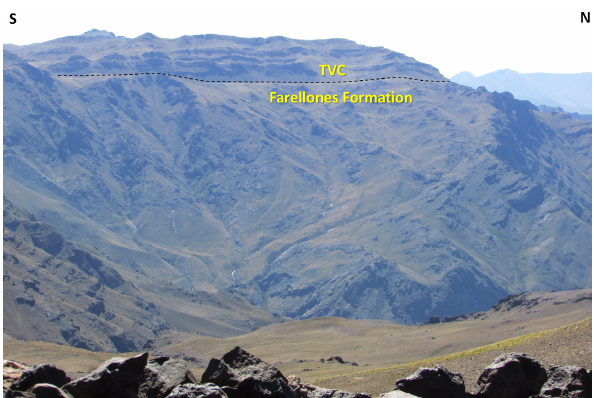
Figure 6. Unconformity (dashed line) separating the TVC from the Farellones Formation. View west from the San Pedro de Nolasco vein